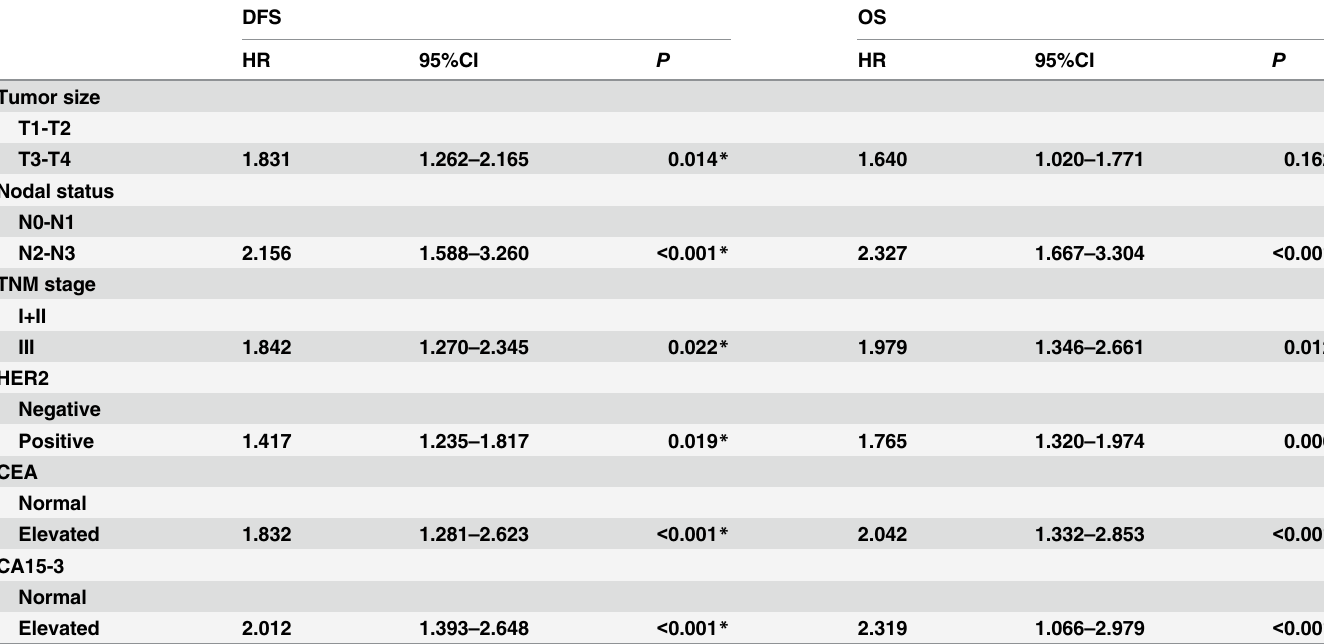
Table 3. Multivariate Cox ’ s regression analysis according to tumor size,nodal status, stage, HER2 status, and serum tumor